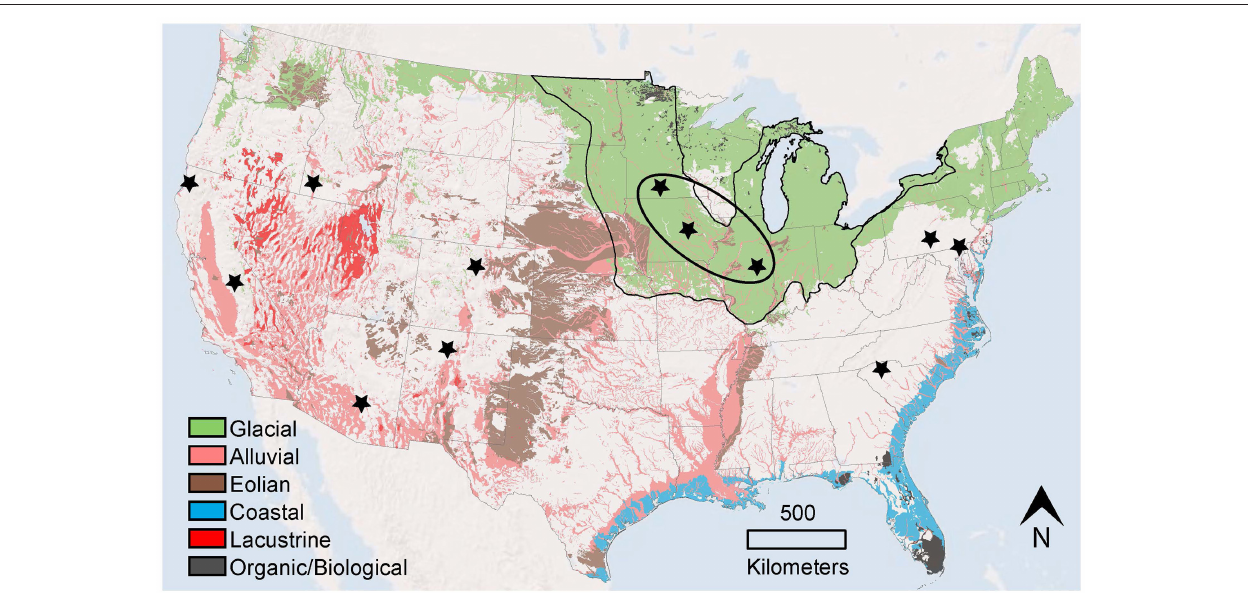
FIGURE 1 | Generalized map showing surficial materials (Source of data: U.S Geological Survey, Soller et al., 2009) and the locations of CZO field observatories within the conterminous United States. The glaciated portion of the Central Lowland of the Interior Plains (Source of data: U.S Geological Survey, Fenneman and Johnson, 1946) is indicated by the narrow black line. The US CZO network is indicated by the black stars with the exception of Loquillo, Puerto Rico, which is not within the map area. The bold black oval surrounds the three IML-CZO field sites. Colored areas denote continuous cover of unconsolidated sediment. Green “Glacial” areas are underlain by glacial till, glaciofluvial, glaciolacustrine, and ice contact deposits. Brown “Eolian” are areas where loess or dune sand is at least 20 feet (6m) thick at the surface. Blue “Coastal” areas contain both fine-grained sediments characteristic of lagoons and estuaries and coarser beach or shoreline deposits. The red “Lacustrine” areas are underlain by lake and playa deposits. Salmon-colored “Alluvial” areas are underlain by alluvial and colluvial deposits along major river valleys and inland basins. The dark gray areas “Organic/Biological” include recent organic sediments (peat) and biological sediments (marl and shelly materials). The white areas include bedrock or residuum developed from weathering of the underlying